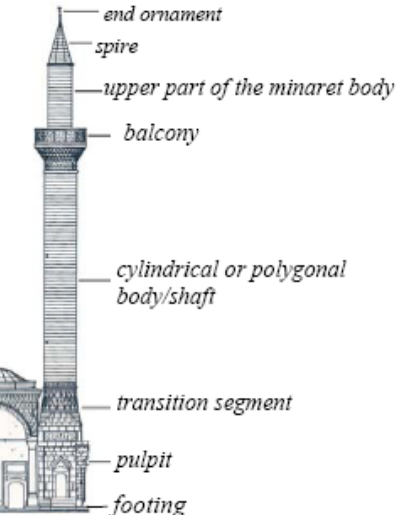
Figure 2 Segments of the classical Ottoman style and İ skenderpa ş a minarets Fig. 2. Segments of the classical Ottoman style and ˙Iskenderpas¸a minarets.